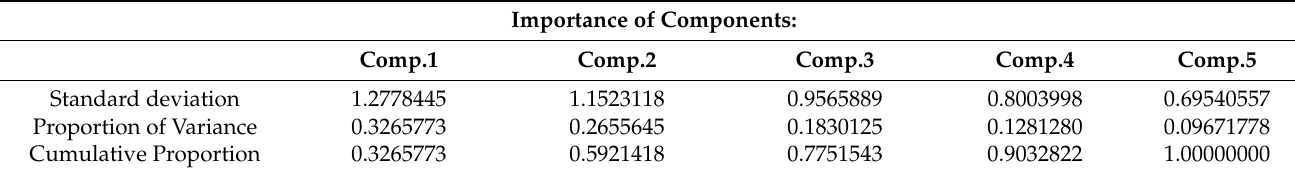
Figure 1. Eigenvalues of the correlation matrix R µ . Table 3. The PCA results calculated using the R program are as